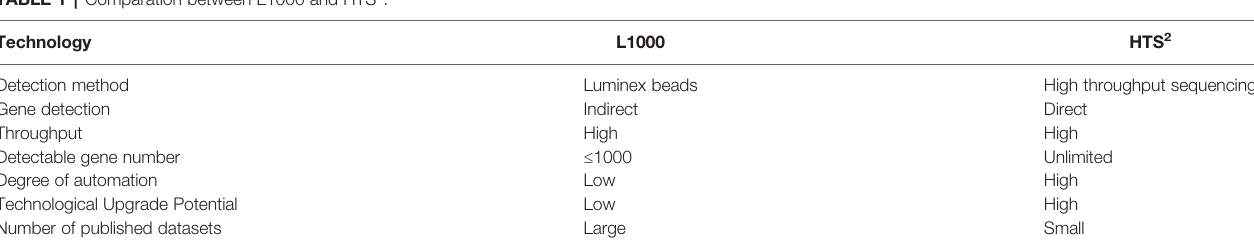
TABLE 1 | Comparation between L1000 and HTS 2